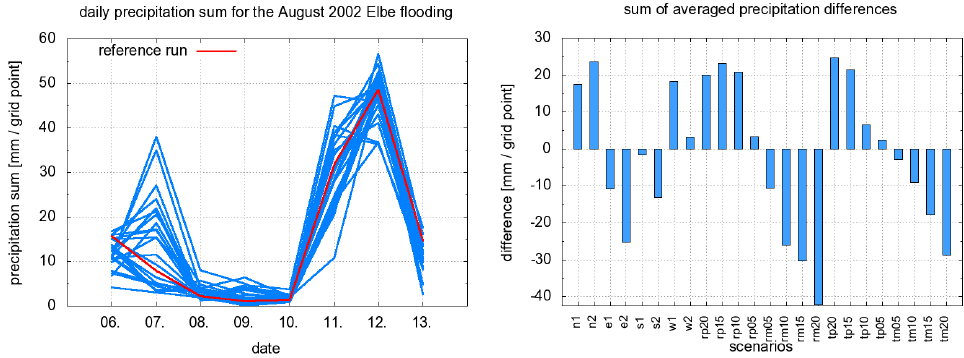
Fig. 2. Time series of the domain-averaged daily precipitation sum of the reference run (7km) and the scenarios for the August 2002 Elbe flooding event (left) and the sum of the differences with respect to the reference run